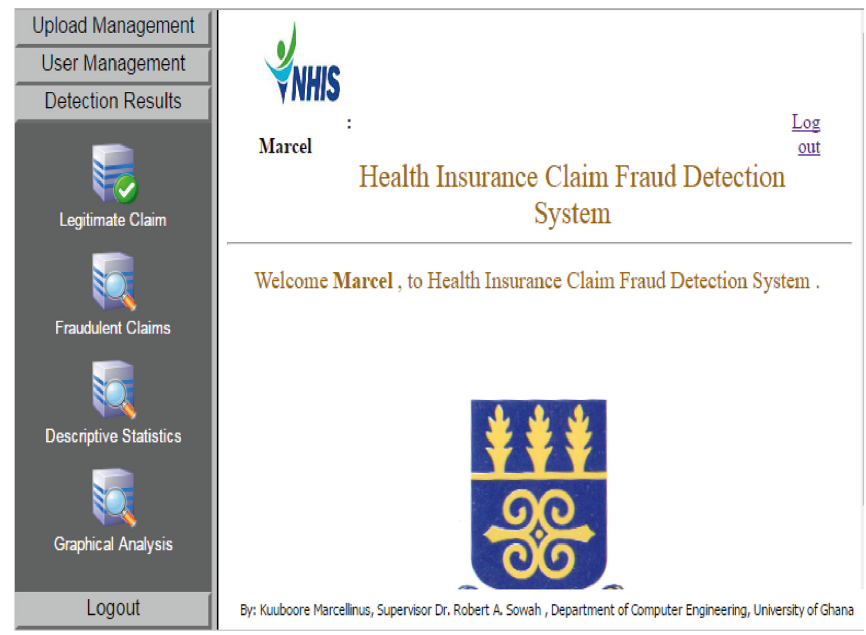
Figure 9: Detection results control portal